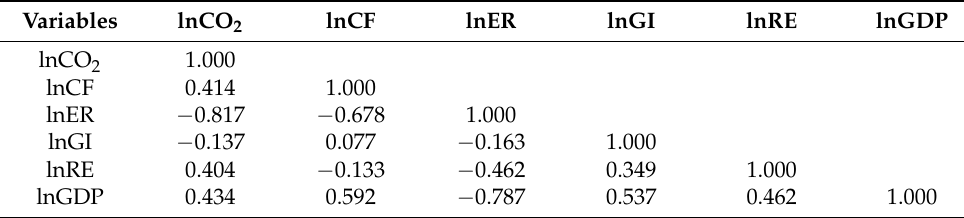
Table 3. Pairwise